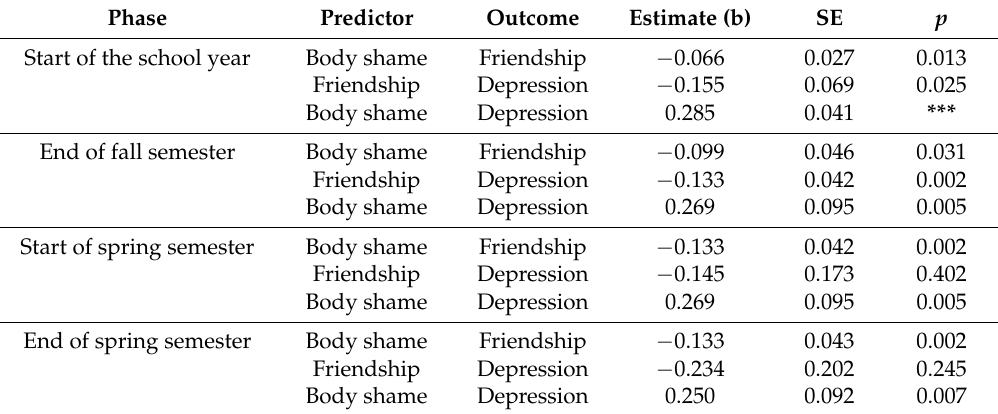
Table 4. Mediation analysis examining friendship on the relationship of body shame to men students’ depression levels ( n = 508). *** p <